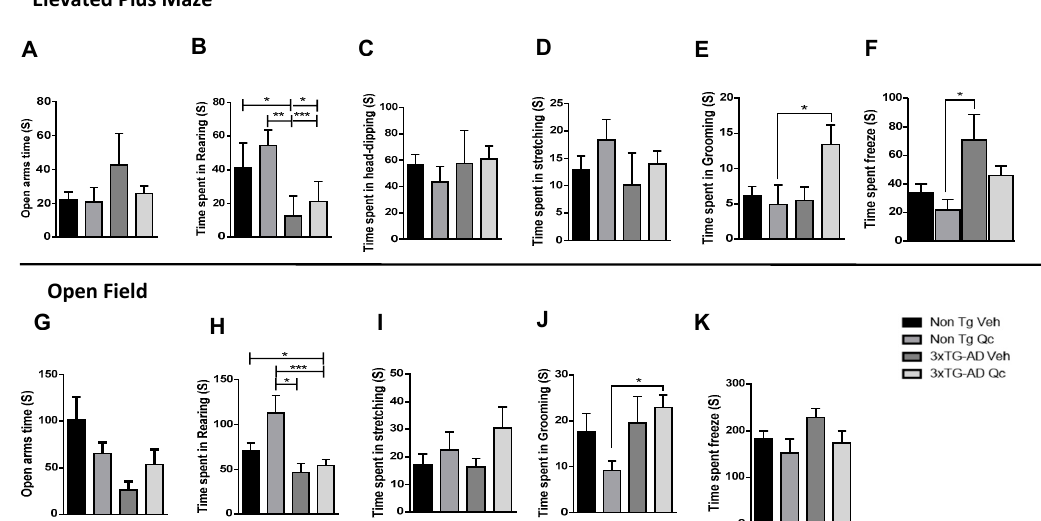
Figure 4. E ff ect of quercetin oral administration on the emotional behavior of 3xTg-AD mice. Elevated plus maze: Time spent on the open arms ( A ). Time spent rearing ( B ), head-dipping ( C ), stretching ( D ), grooming ( E ), and freezing ( F ). Open field: Time in the center ( G ). Time spent on rearing ( H ), stretching ( I ), grooming ( J ), and freezing ( K ). The measurement of time is expressed in seconds. The data are represented as the mean ± SEM. n = 4–19. * p : < 0.05; ** p : < 0.01; *** p < 0.001.